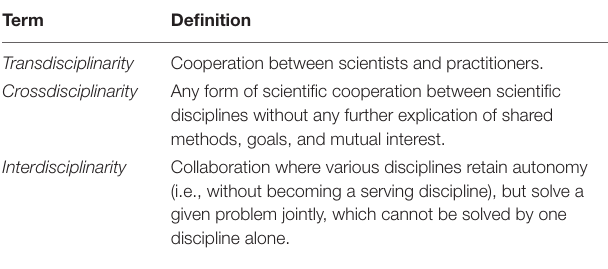
TABLE 1 | Definitions based on Wagner et al.